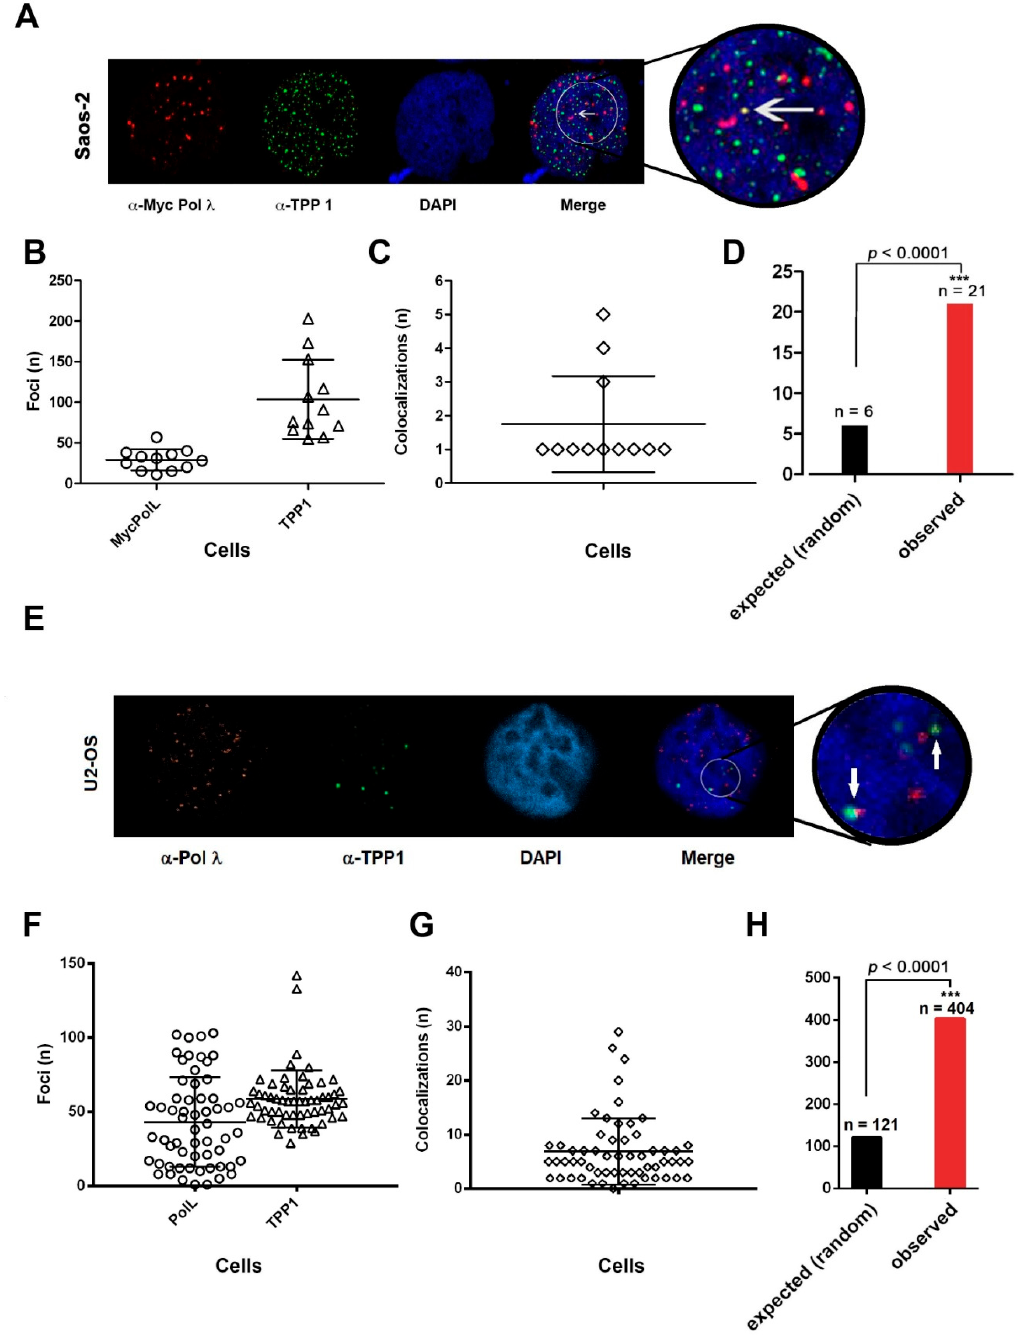
Figure 7. DNA polymerase λ associates with TPP1 in ALT cells (A-D Saos-2; E-H U2OS). ( A ) Confocal microscopy imaging of Pol λ colocalization with TPP1 in Saos-2 cells stably expressing c-Myc Pol λ . The white arrow indicates a representative colocalization event. ( B ) Number of foci detected for Myc-Pol λ (circles) and TPP1 (tringles) per cell. ( C ) Number of